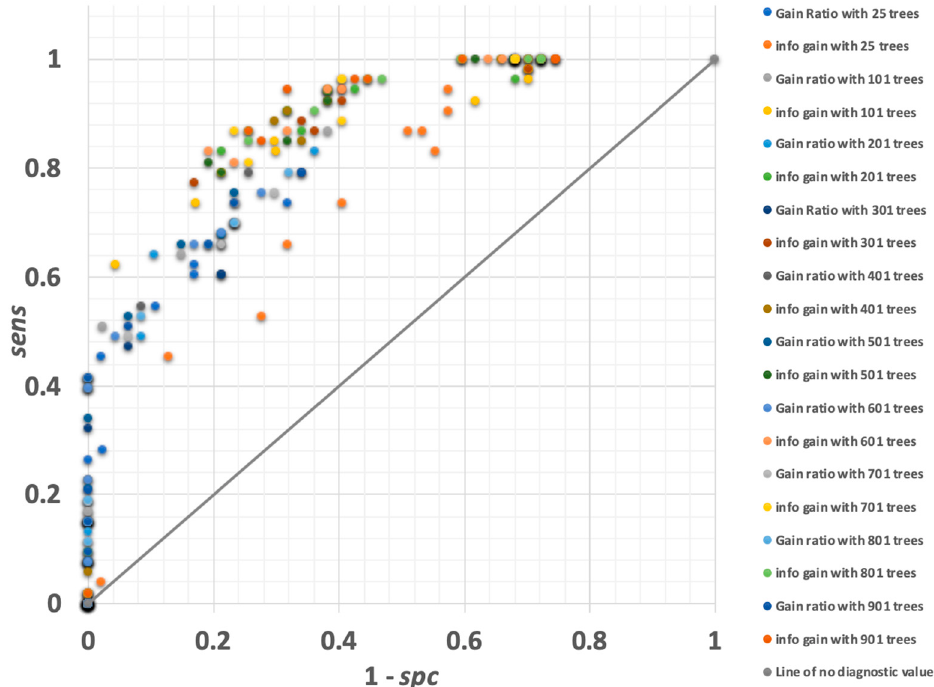
Figure 4. ROC curve for all random forest models explored. Models differ by adjusting parameters within RapidMiner. 'Gain ratio' and 'info gain' refer to criteria on which attributes will be selected for splitting within RapidMiner software. The optimal random forest model performed well, achieving sens = 0.83, spc = 0.81, and 82% of the scoring milk samples assigned to the correct diagnostic category.